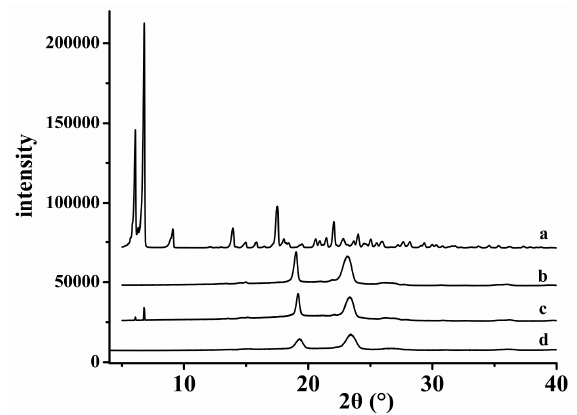
Figure 5. XRD results (2 θ = 5–40 °) of the samples: ( a ) free HK; ( b ) HK–PLX (1:4) SD; ( c ) physical mixture of HK and PLX; ( d ) PLX.